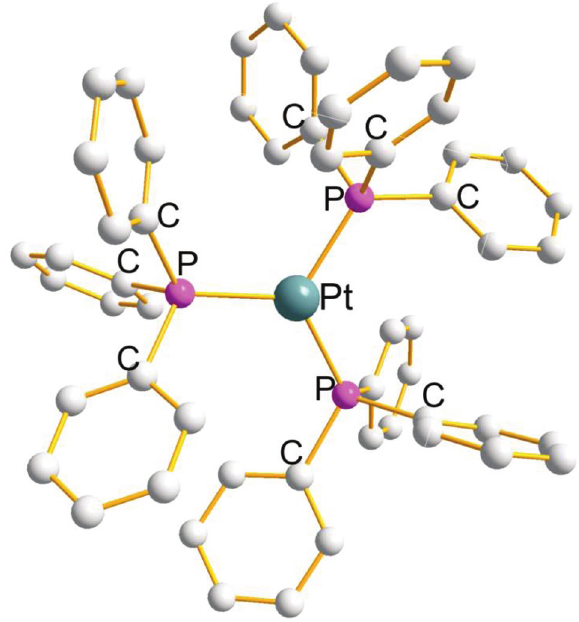
Figure 1: Structure of [Pt(PPh